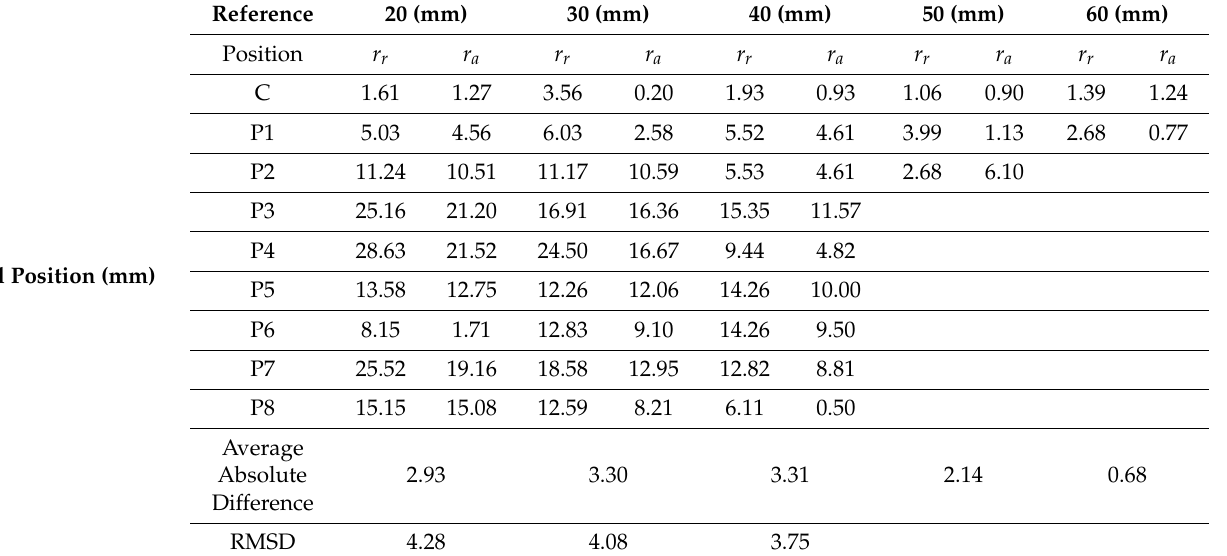
Table 3. Radial position obtained for different concentric and eccentric cases. r r is the experimental radial position estimated using Equation (1). r a is the radial position calculated using the algorithm.